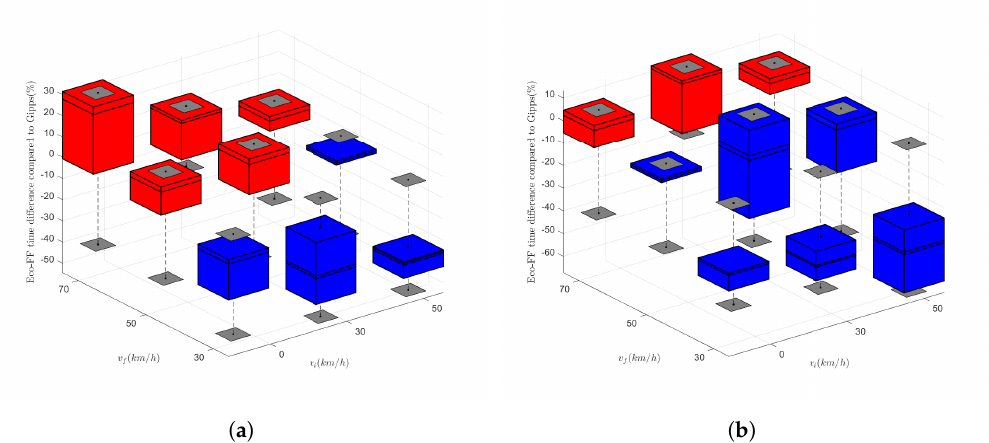
Figure 6. Eco-FF travel time difference compared to the Gipps with low and high auxiliary power consumption levels. ( a ) c 4 = 970 (W). ( b ) c 4 = 2550